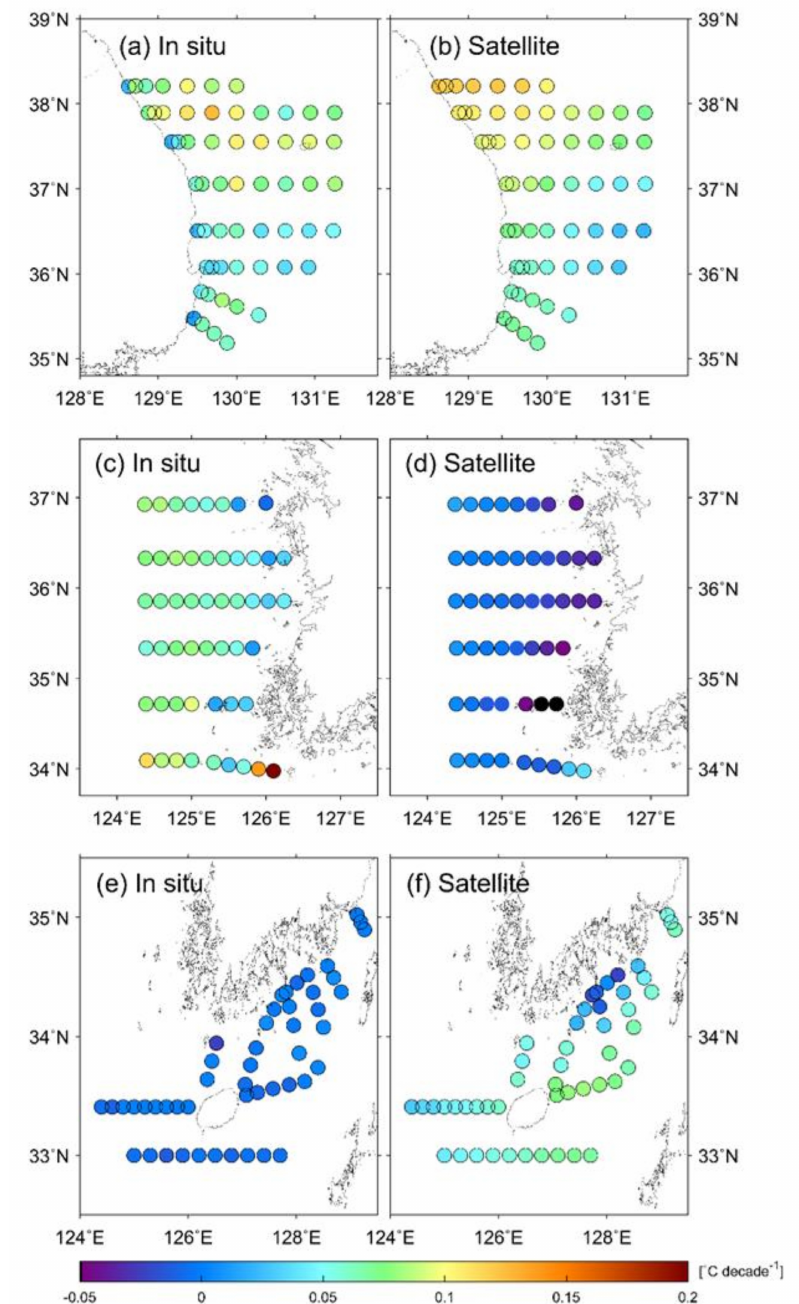
Figure 10. Trends ( ◦ C decade − 1 ) of in situ surface water temperatures measurements and satellite SSTs at the KODC stations ( a , b ) in the East / Japan Sea, ( c , d ) in the Yellow Sea, and ( e , f ) in the southern region, where black circles represent statistically significant trends with 95%-confidence